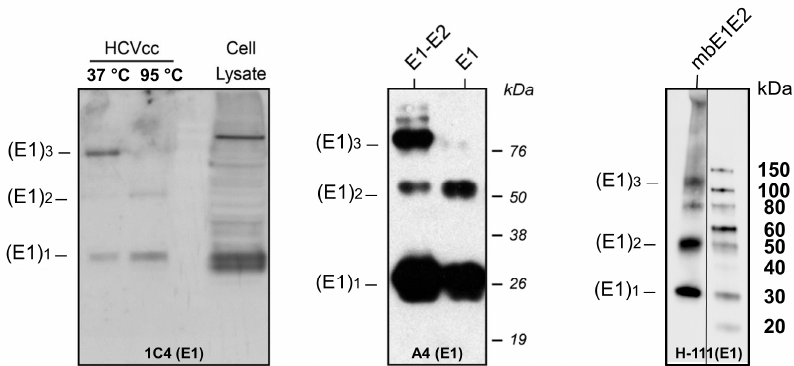
Figure 4. Analysis of HCV E1 trimer formation in different platforms. Nondenaturing (or denaturing, as indicated) Western blot for HCVcc (left), HCVpp (middle), and purified mbE1E2 (right) using the antibodies indicated in each panel. Molecular mass markers (in kilodaltons) are indicated on the right. The oligomeric forms of E1 are indicated on the left. The left and middle panels are reproduced with permission from [116]. In the right panel, duplicate and/or irrelevant lanes between the displayed sample and the marker were deleted for the sake of clarity (indicated by a vertical line).